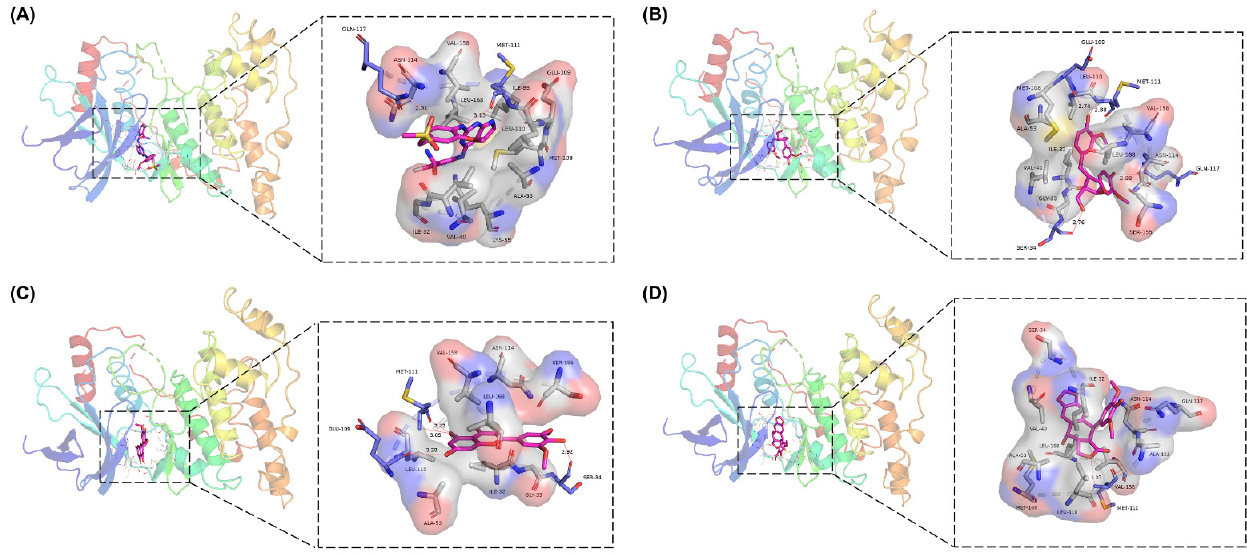
Figure 6. Three-dimensional presentations of the interactions between ligands and JNK1. ( A ) Co- crystallized ligand, ( B ) Lariciresinol, ( C ) Tricin, and ( D ) 4 ′ -Demethylepipodophyllotoxin.